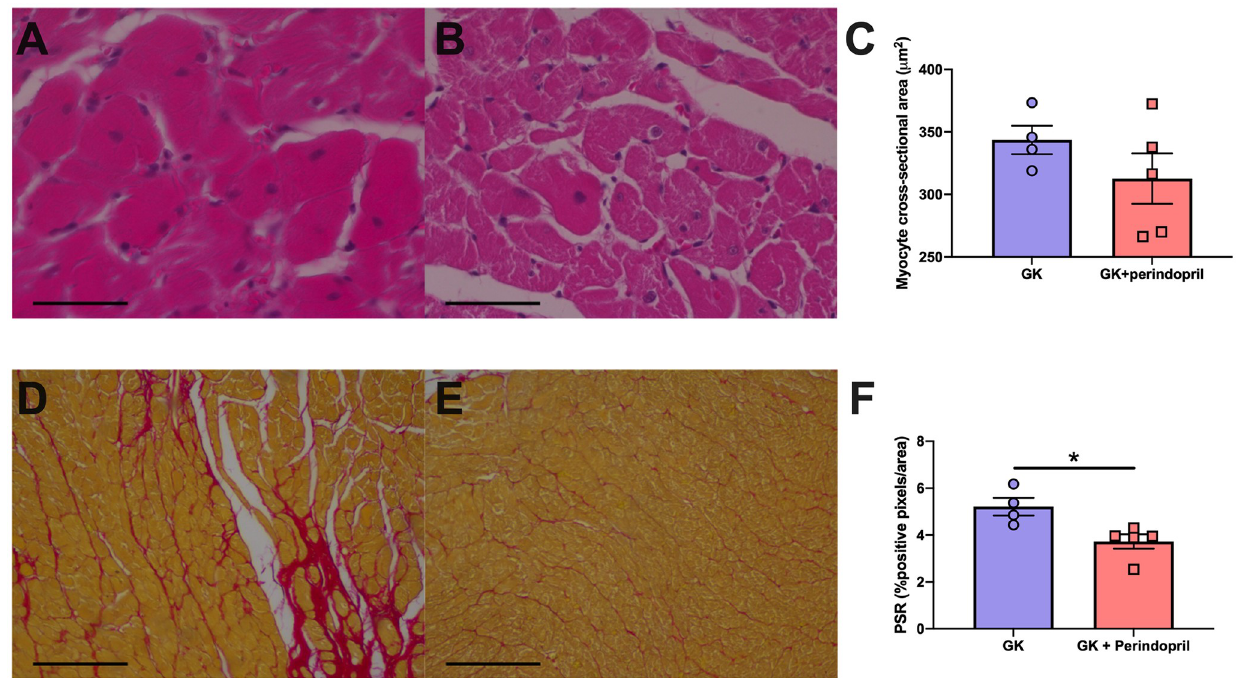
Fig 6. Cardiac structure in control GK rats and GK rats treated perindopril. Representative hematoxylin and eosin-stained sections and PicroSirius red stained sections. Hearts of Goto Kakizaki (A,D) rats and Goto Kakizaki rats treated with Angiotensin Converting enzyme inhibitor perindopril (B,E) had myocyte hypertrophy (C) and fibrosis (F, positive PSR stained pixels) measured. Parameters were measured in Goto Kakizaki rats either treated with saline (GK) or ACE inhibitor perindopril (GK + perindopril). � = p < 0.05, when compared to GK rats (student’s t-test was used to compare groups). Data is expressed as mean ± SEM N = 4–5 per group. Scale bars (A-B) 50 μ m and (C-D) 300 μ m.